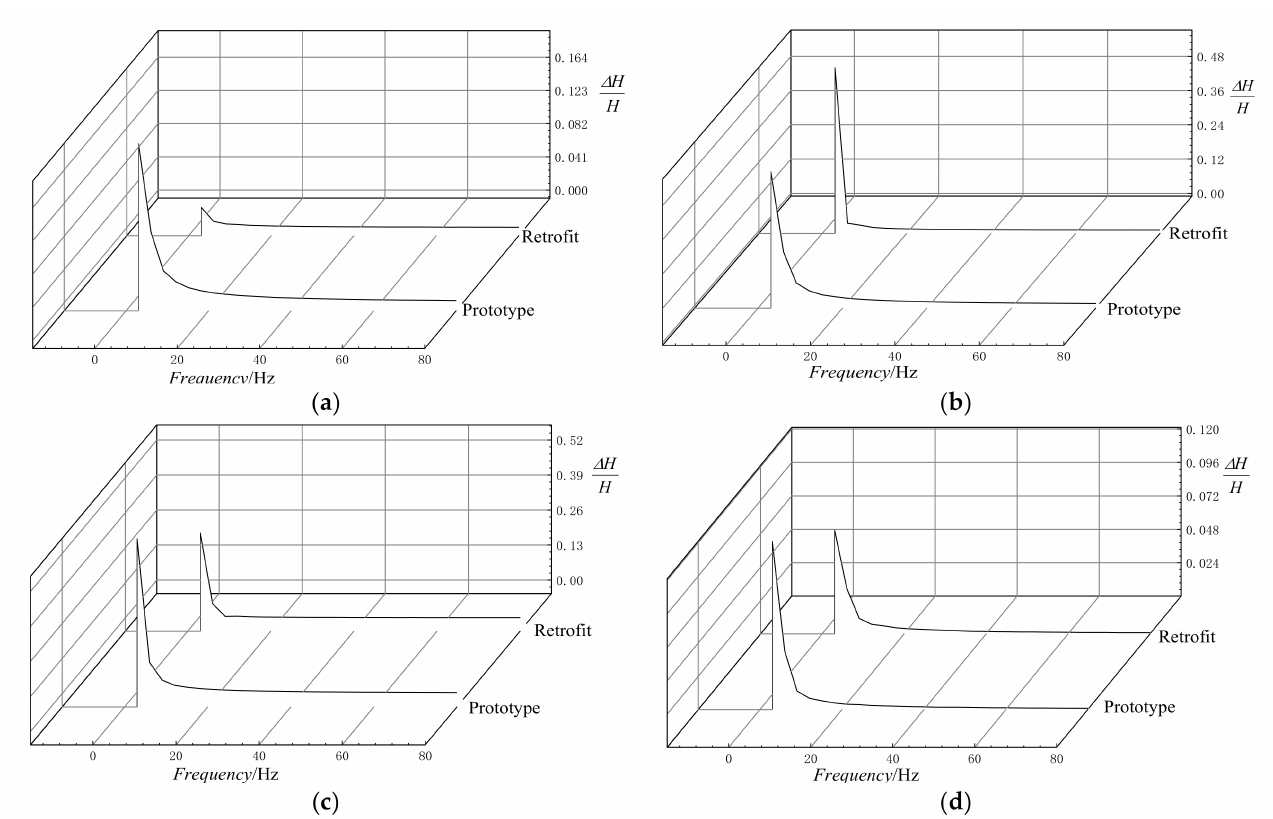
Figure 15. Monitoring point pressure pulsation frequency domain diagram. ( a ) d 1 Time domain curves. ( b ) d 3 Time domain curves. ( c ) d 5 Time domain curves. ( d ) d 7 Time domain